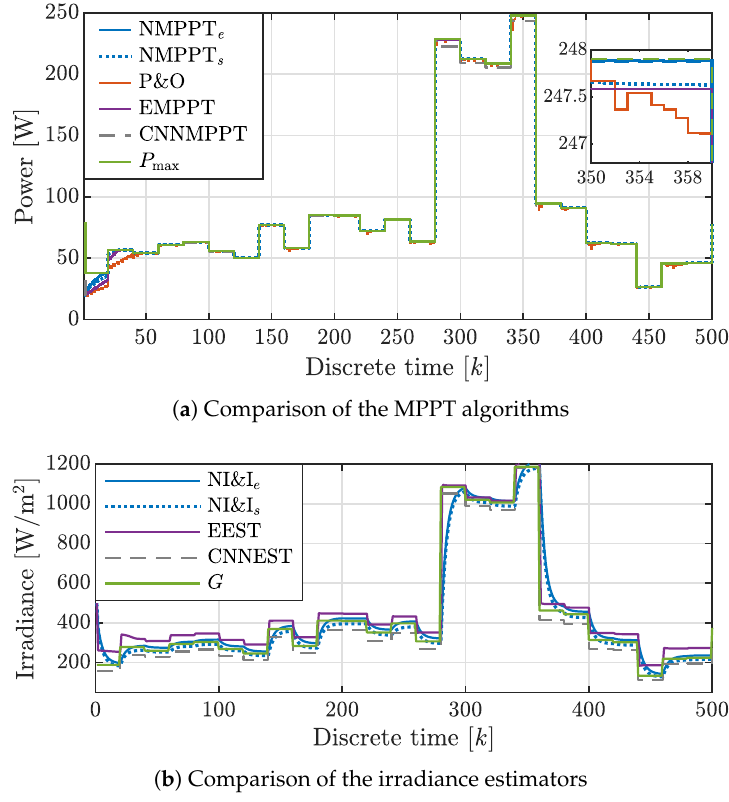
Figure 14. Comparison of the algorithms under time varying profile of the solar irradiance. Table 2. Relative error between the predicted and true maximal